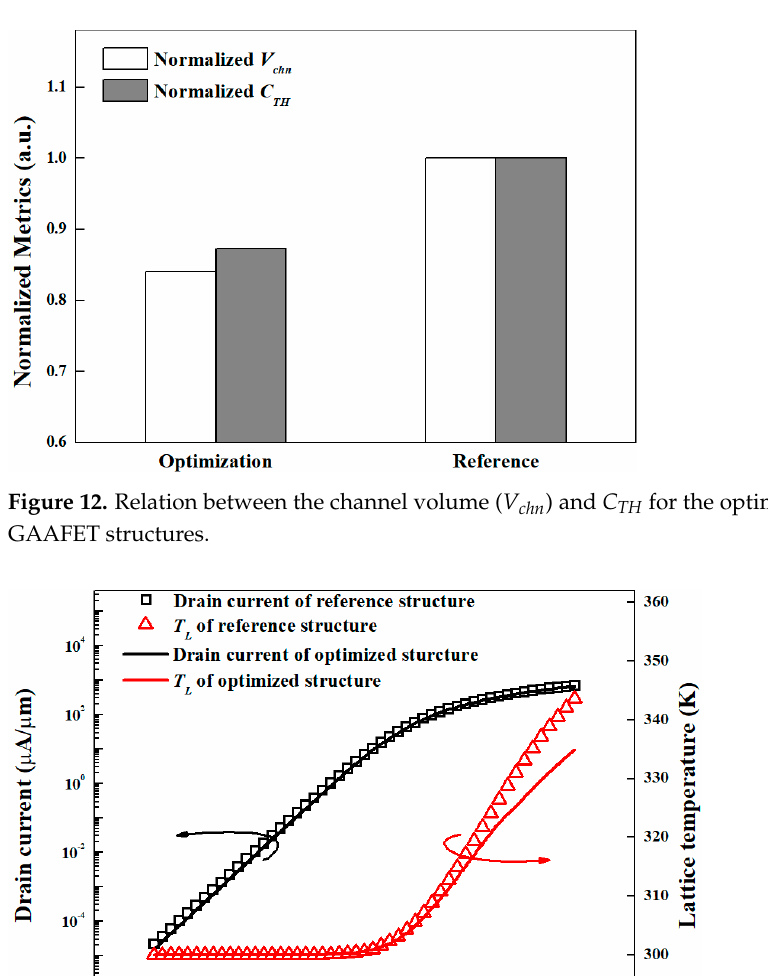
Figure 11. Optimization results of R TH , C TH , and τ TH properties.